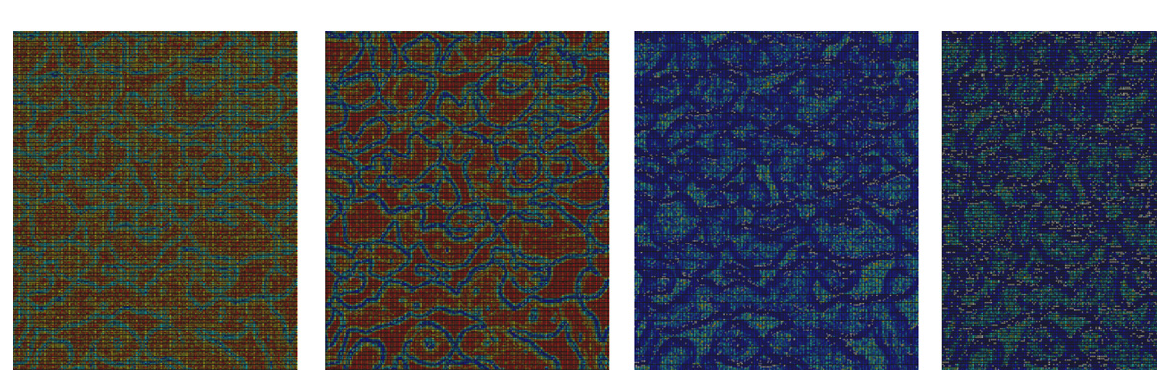
Figure 23: Entropy 8 gray levels.